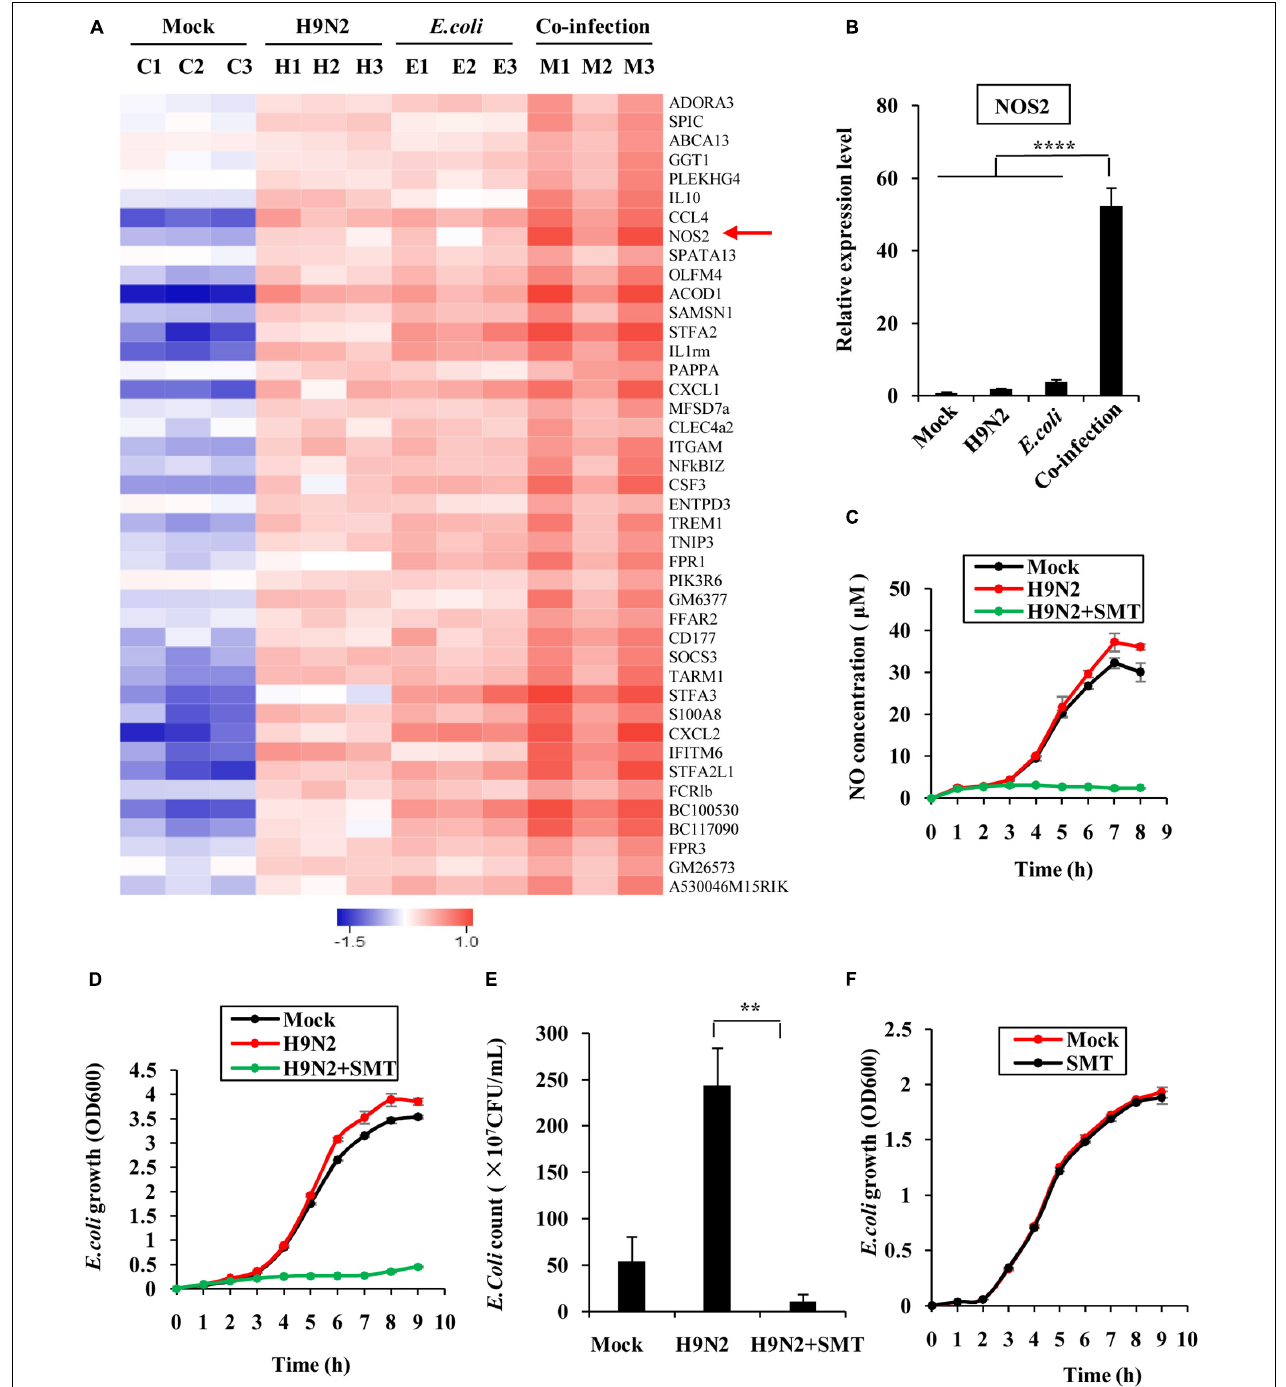
FIGURE 7 | Increased NOS2 expression promotes E. coli proliferation. (A) RNA sequencing was used to determine the differentially expressed genes in mouse lungs infected for 48 h between individual infection and co-infection groups. All the genes whose expressions were upregulated and changed by at least 2-fold were displayed. The red arrow highlight the upregulated NOS2 genes. (B) The mRNA expression level of NOS2 in mouse lungs was examined by quantitative real-time PCR. (C) MLE12 cells were infected with or without H9N2 (MOI = 1) for 12 h, followed by E. coli (MOI = 10) infection with or without S-Methylisothiourea Sulfate (SMT) treatment. NO production in culture supernatants at the indicated time point was measured by NO assay kit. (D) MLE12 cells were infected with or without H9N2 as described in (C) . OD 600 of E. coli in cell culture supernatants at the indicated time point was measured by spectrophotometer. (E) MLE12 cells were infected with or without H9N2 (MOI = 1) for 12 h, followed by E. coli (MOI = 10) infection with or without SMT treatment. After 6 h, the number of E. coli in cell culture supernatants was counted. (F) E. coli cultured in antibiotic-free DMEM was treated with SMT or vehicle control. OD 600 of E. coli in the supernatants at the indicated time point was measured by spectrophotometer. Data are presented as the mean ± SD of three independent experiments. ** P < 0.01, **** P < 0.0001.